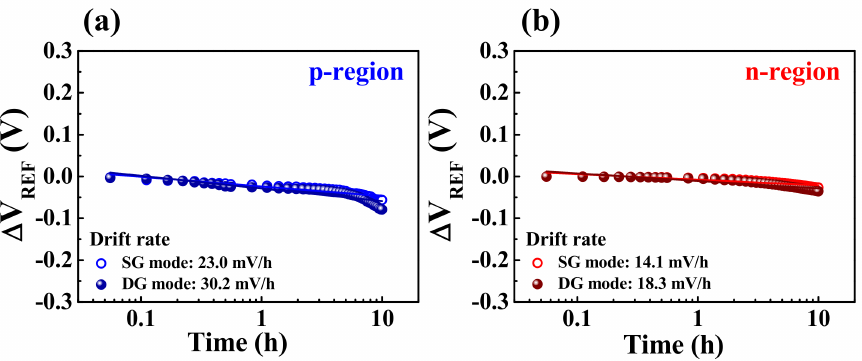
Figure 8. Drift effects of the ambipolar DG ISFET in the ( a ) p region and ( b ) n region when the sensing membrane is immersed in a pH 7 buffer for 10 h. ∆ V REF was monitored in the SG and DG sensing modes.